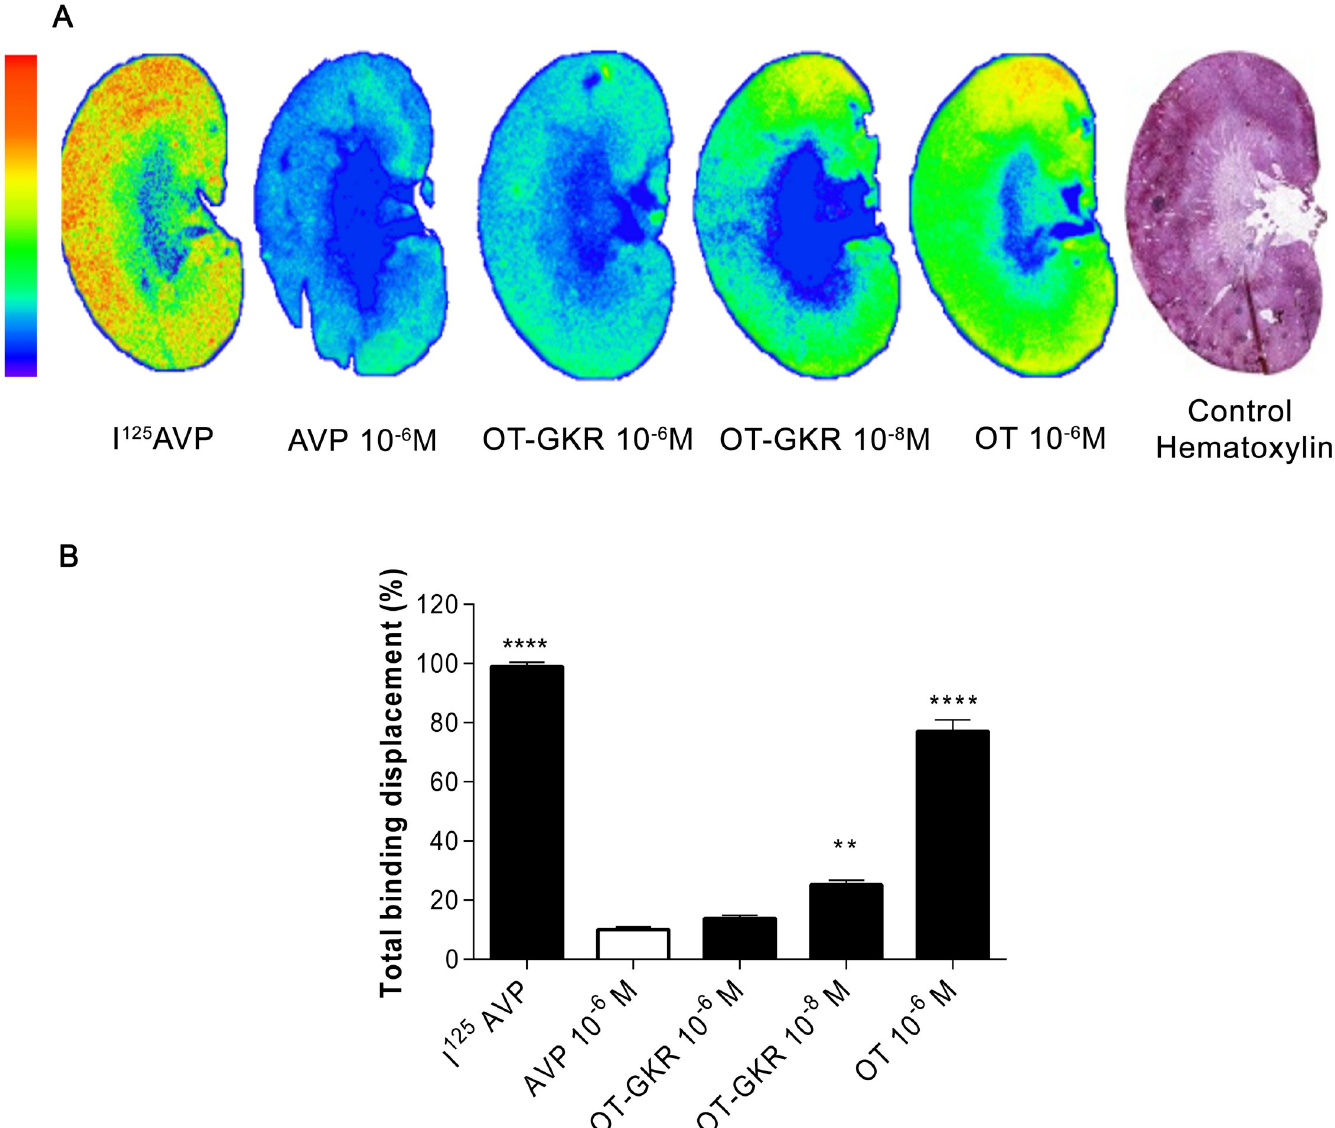
Fig 4. Autoradiography kidney representations of AVP, OT-GKR and OT in competition with I 125 AVP. (A). Representative images of autoradiography registered by Phosphorimager. (B) The competitive binding efficiency of AVP, OT-GKR, OT, with I 125 AVP. Statistical analysis: One-way ANOVA with a Dunnett’s post-test. � : p < 0.05, �� : p < 0.01, ��� : p < 0.001 vs total binding displacement.